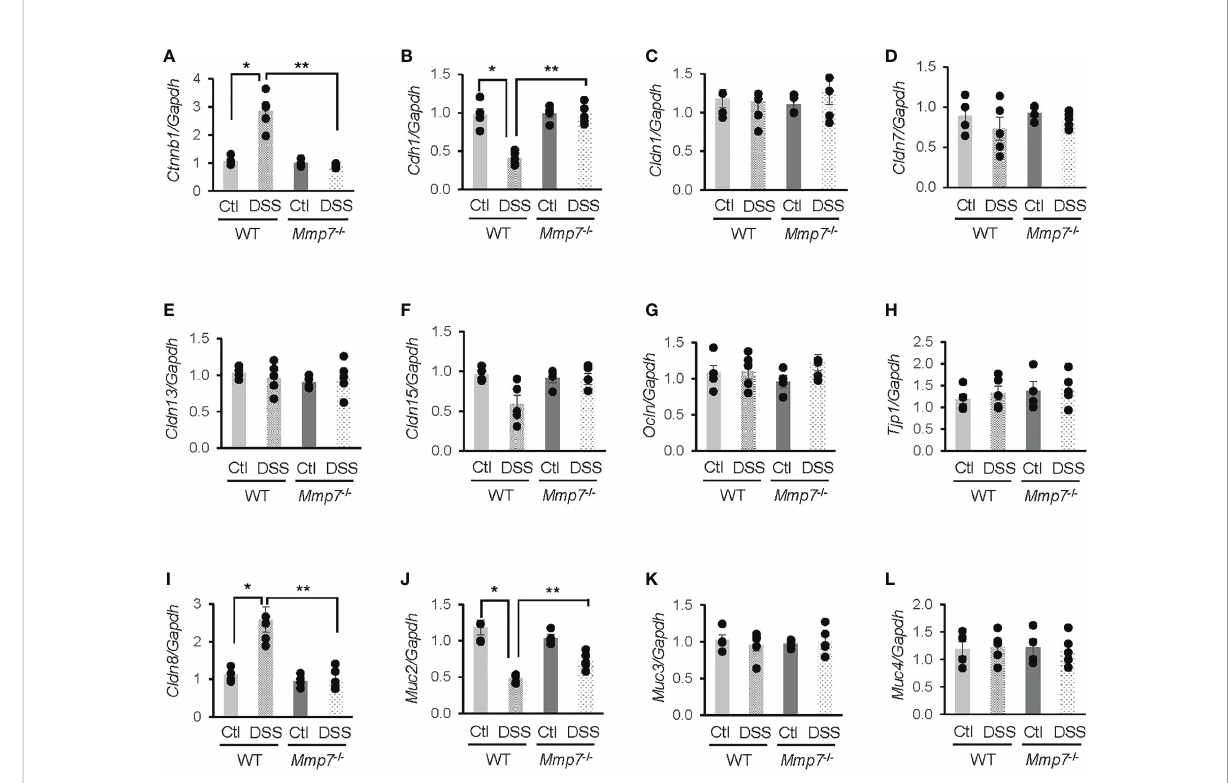
FIGURE 5 Differential mRNA expression of junction proteins in the colons of wild type and Mmp7 -/- mice treated with 3% DSS. Colitis was induced with 3% DSS in drinking water in both C57BL/6 and Mmp7 -/- mice for 7 days as shown in Figure 4. RT-qPCR was performed to determine mRNA levels of Ctnnb1 (A) , Cdh1 (B) , Cldn1 (C) , Cldn7 (D) , Cldn13 (E) , Cldn15 (F) , Ocln (G) , Tjp1 (H) , Cldn8 (I) , Muc2 (J) , Muc3 (K) , and Muc4 (L) . n=4 or 5. * p <0.05 vs wild type control. ** p <0.05 vs wild type